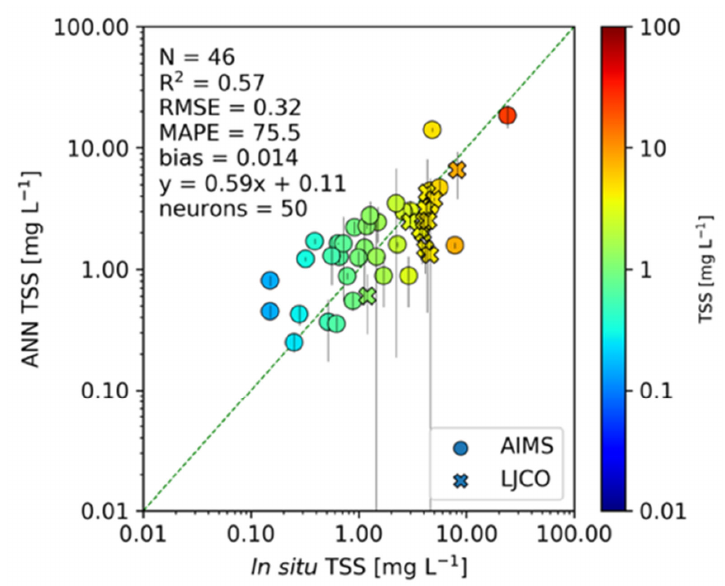
Figure 5. In situ and Himawari-8-derived TSS with the best-performing ANN experiment, with in situ TSS values colour-coded in logarithmic scale. Error bars represent the intra-pixel standard deviation of TSS within a 3-by-3-pixel box. Different symbols indicate in situ data collected by AIMS and by CSIRO at LJCO.